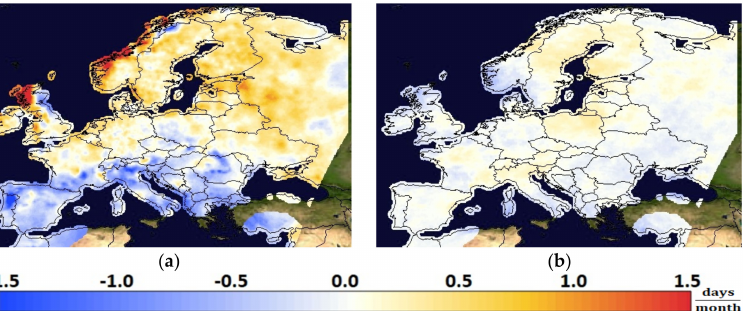
Figure 7. Mean change in the number of days/month with mean precipitation over 5 mm observed (E-OBS, left panel) and the related model bias (E-OBS-model, right panel) between current (1981–2010) and historic (1951–1980) periods ( a ) Observed (E-OBS) ( b ) Model bias